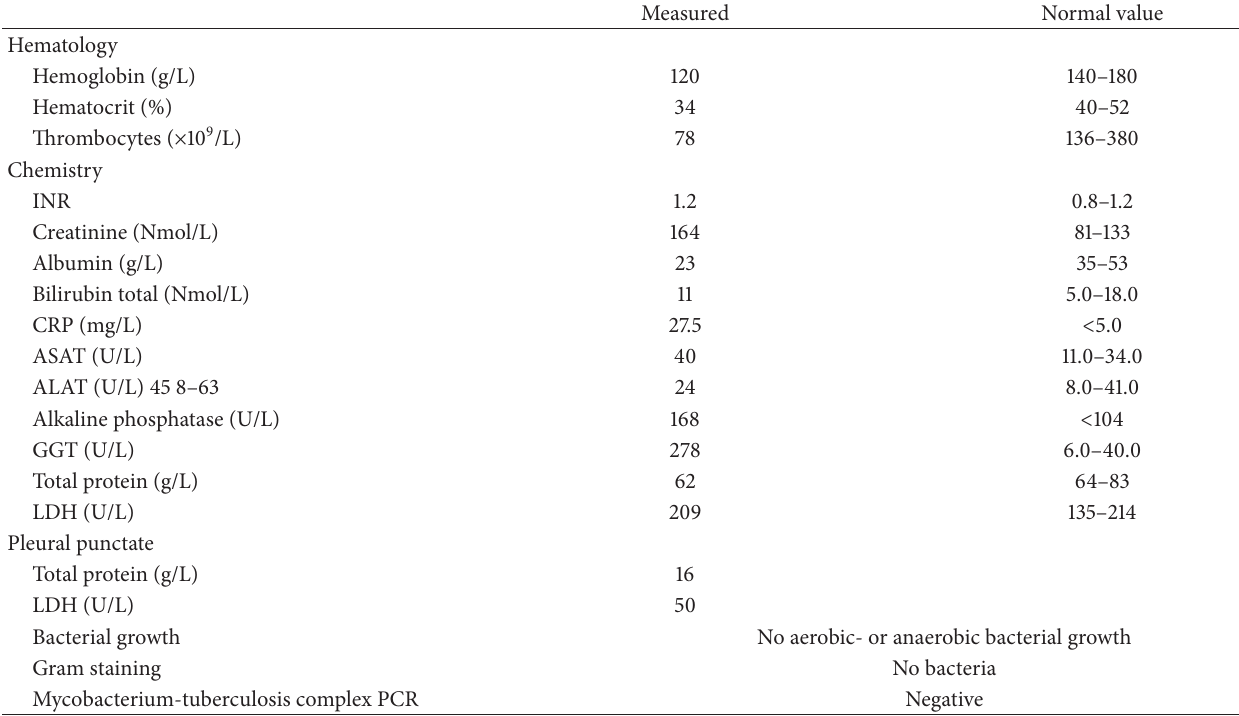
Table 1: Summary of important laboratory values.